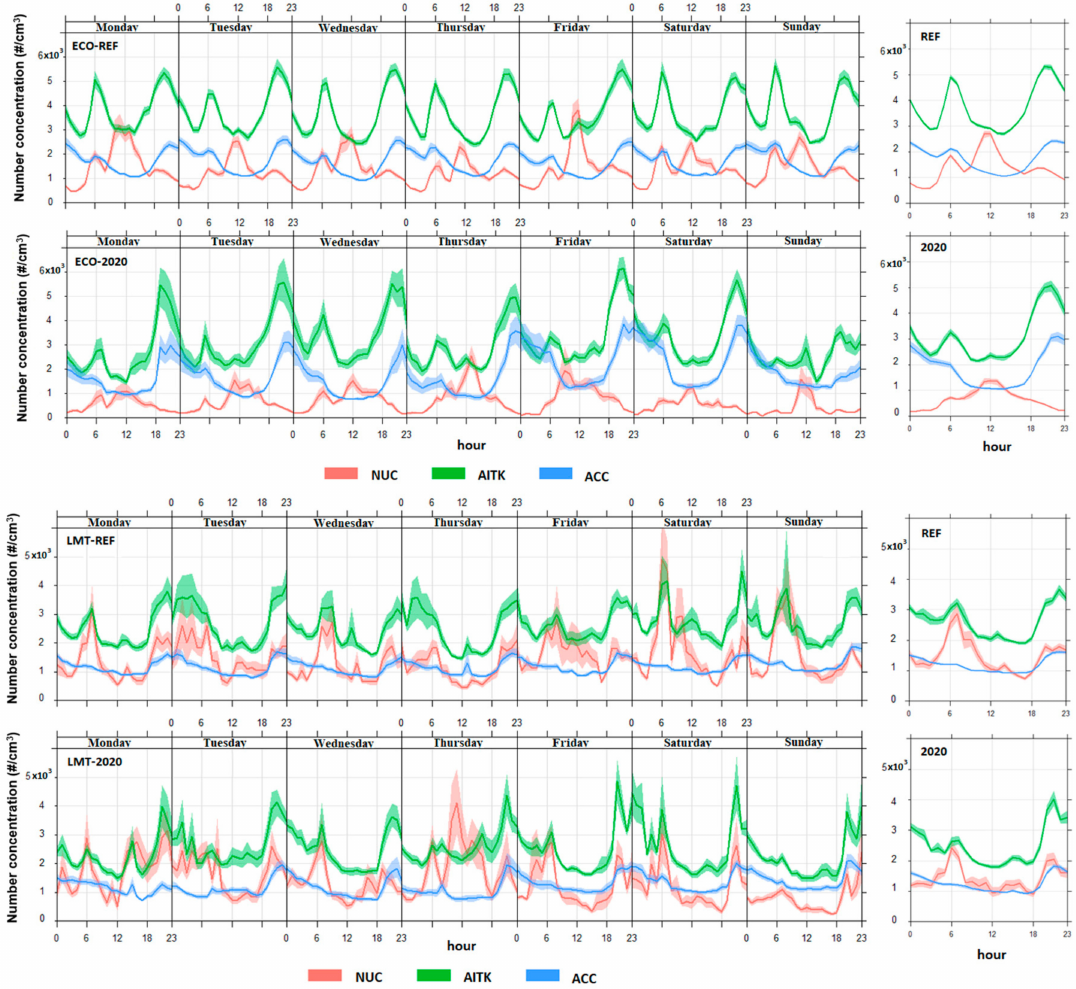
Figure 5. Percentage weekly average cycle of particle number concentration, N nuc (Dp < 20 nm), N aitk (20 nm < Dp < 100nm) and N acc (100 nm < Dp < 800 nm), collected from 10 March to 17 May of 2020 and the reference (2015–2019) years, in ECO and